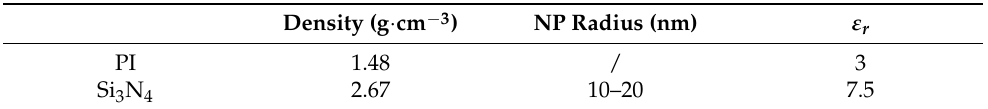
Table 1. Materials properties: density, NP radius, and relative static dielectric permittivity ε r (i.e., dielectric permittivity at low